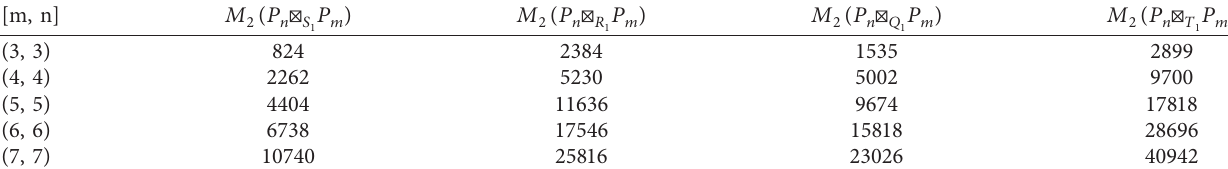
( P P ) for path n ⊠ Φ 1 m 2